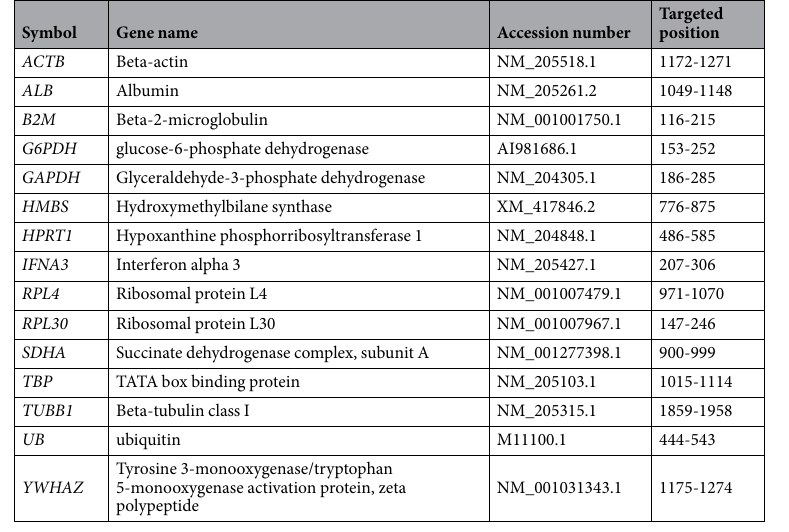
Table 7. List of reference genes being tested in